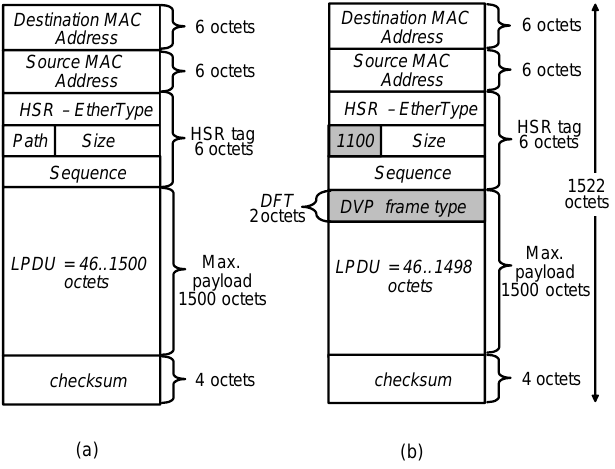
Figure 2. Frame structure for the ( a ) standard HSR protocol and ( b ) DVP